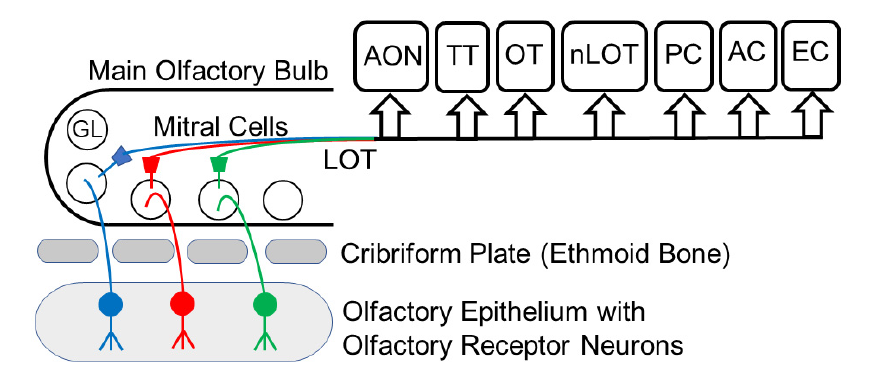
Figure 1. Schematic representation of the olfactory pathway. The olfactory pathway starts with the olfactory epithelium in the nose. Olfactory receptor neurons are bipolar nerve cells that send an axon each through the cribriform plate of the ethmoid bone to the ipsilateral main olfactory bulb. Olfactory receptor neurons synapse on mitral cells and other cells in olfactory glomeruli. Mitral cells send their axons through the lateral olfactory tract to higher-order olfactory centers. The main olfactory bulb houses additional neuron types that are not shown for clarity. The size of the boxes in the olfactory cortex does not represent the actual space occupied by a particular brain region. AC, amygdaloid complex; AON, anterior olfactory nucleus; EC, entorhinal cortex; GL, glomerulus; LOT; lateral olfactory tract; nLOT, nucleus of lateral olfactory tract; OT, olfactory tubercle; PC, piriform cortex; TT, tenia tecta.